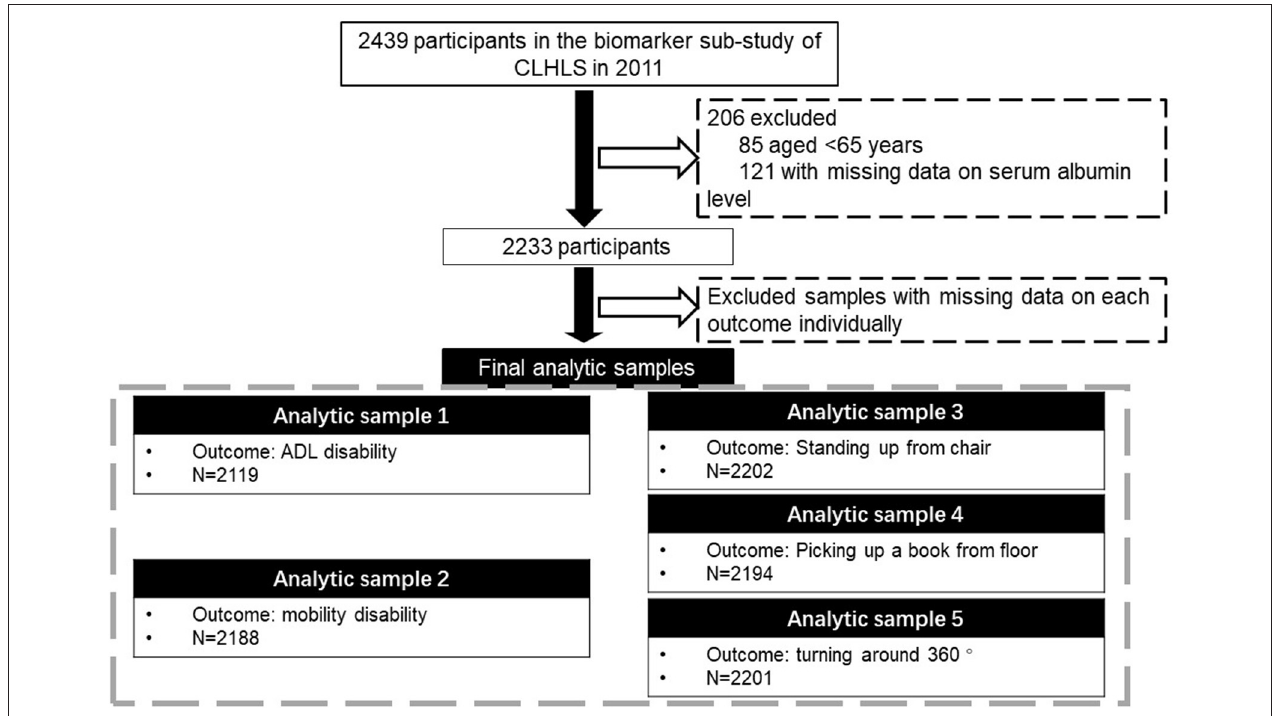
FIGURE 1 | Flowchart of assembling study participants. CLHLS, Chinese Longitudinal Healthy Longevity Survey; ADL, activities of daily